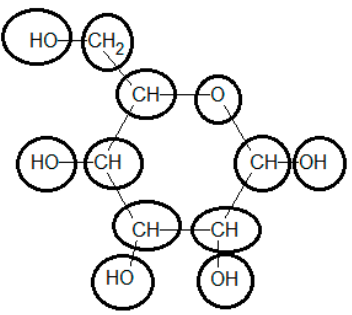
Figure 2. Decomposition of the chemical structure of glucose into groups to estimate its standard Gibbs energy of formation using a group contribution method.